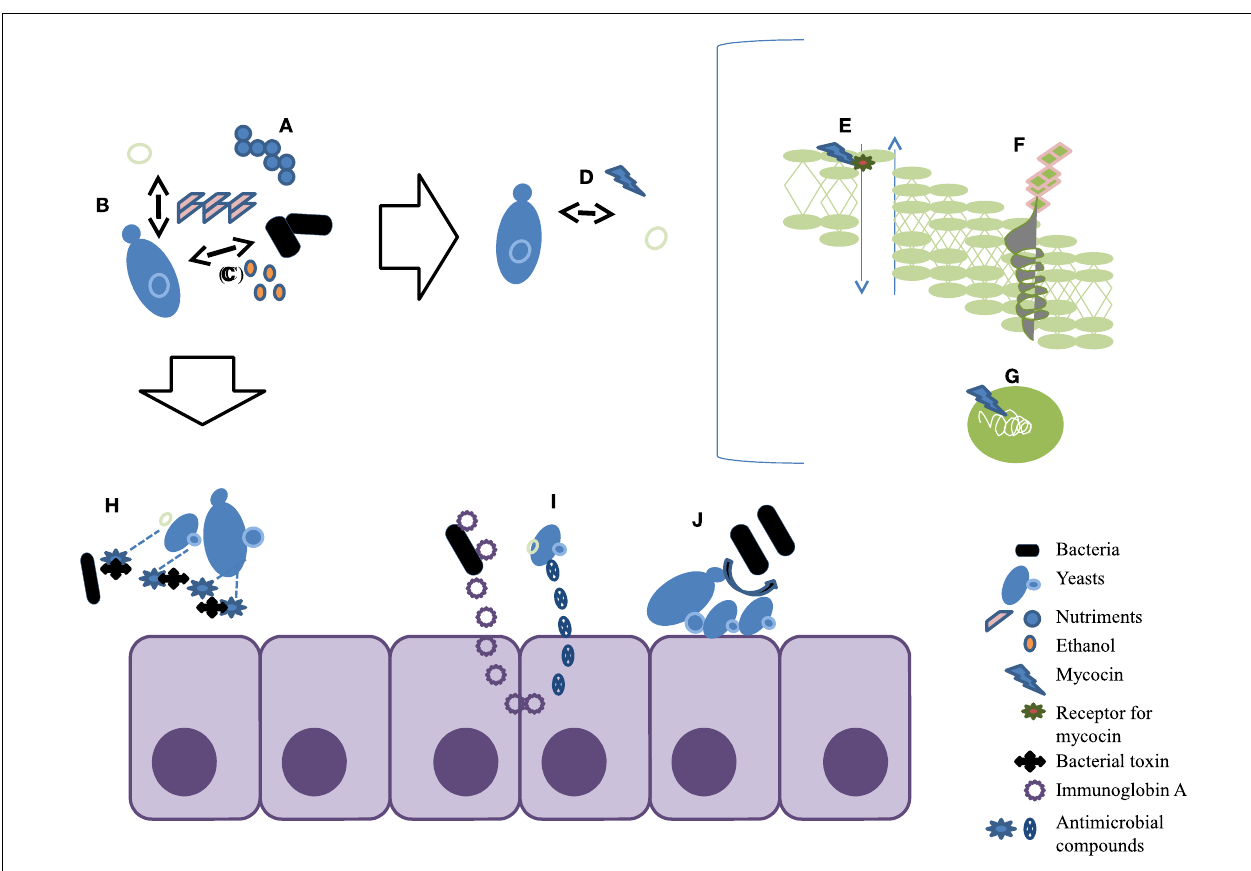
membrane; (F) mycocin inhibits the synthesis of cell wall component β -1,3-glucan; (G) mycocin interrupts cell division by blocking the DNA synthesis; (H) proteases degrade bacterial toxins; (I) stimulate the immune response; (J) yeasts inhibit attachment to intestinal